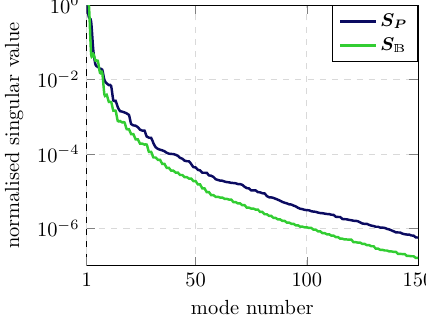
Figure 10. Normalised singular values of the stress S P and induction snapshot matrix S B